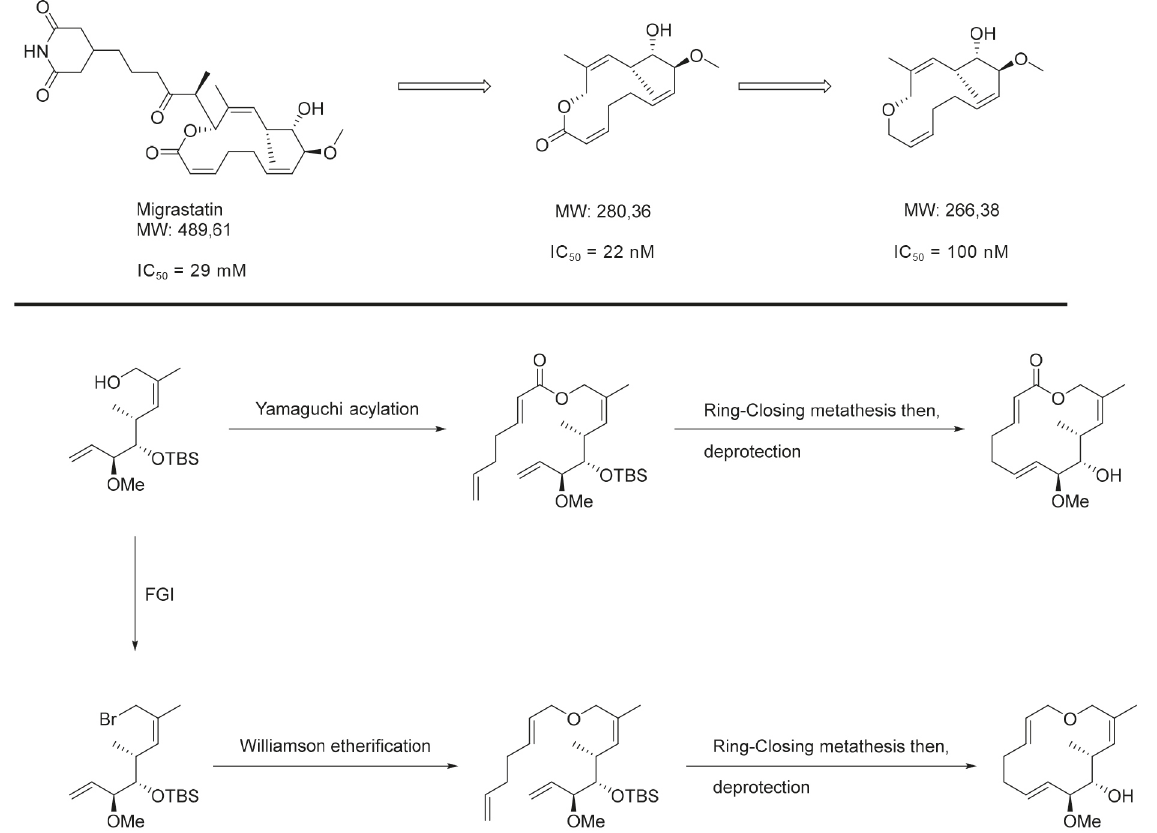
FIGURE 8 - Selection and synthesis of antitumoral fragments derived from high-molecular weight natural